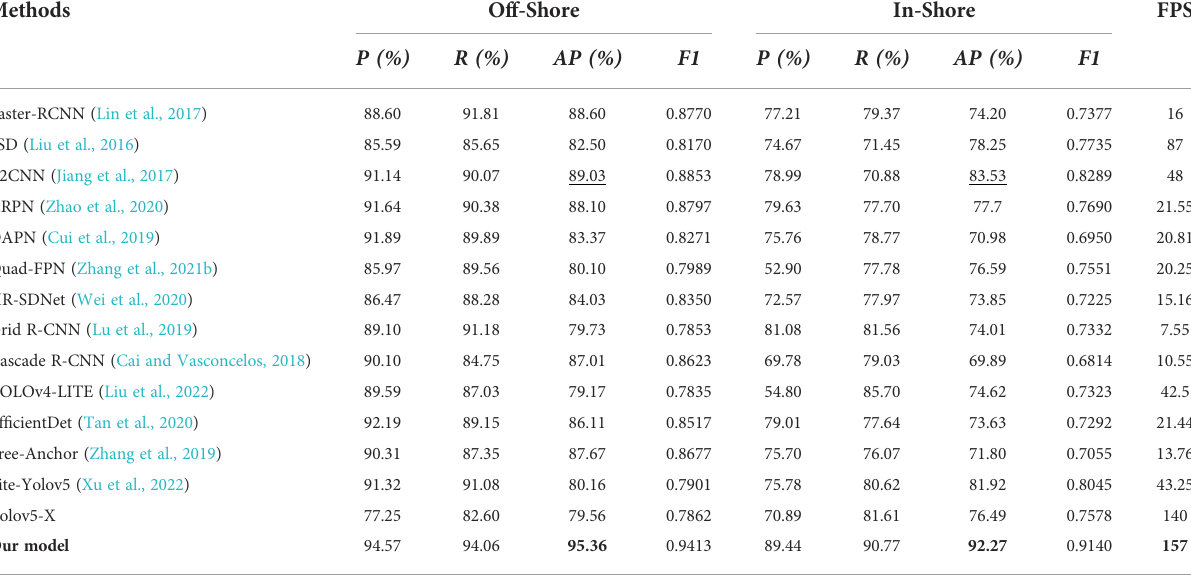
TABLE 3 The identi fi cation outcomes of various state-of-the-art CNN based approaches on offshore and inshore ship scene for SSDD Dataset.